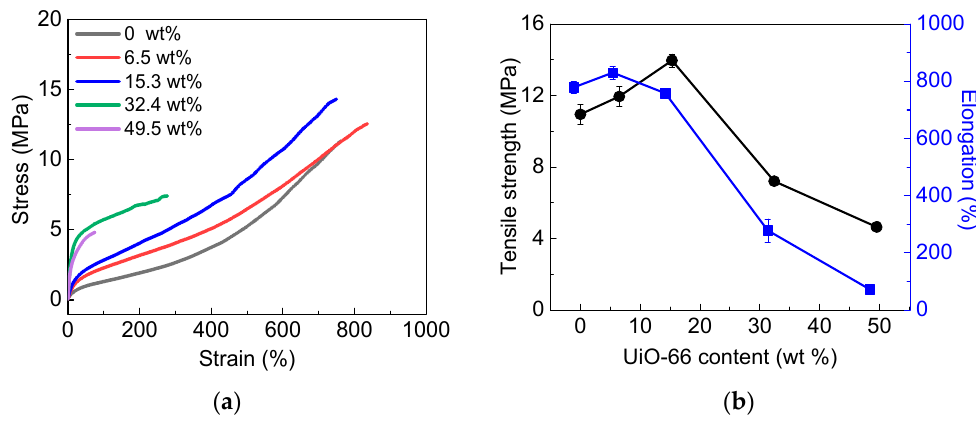
Figure 4. ( a ) Stress–strain curves and ( b ) tensile strengths ( ● ) and elongations ( ▪ ) ( b ) of the composite films prepared using DSPDs with different amounts of UiO-66 particles; DSPD has the APTES content of 2.5 wt.%.